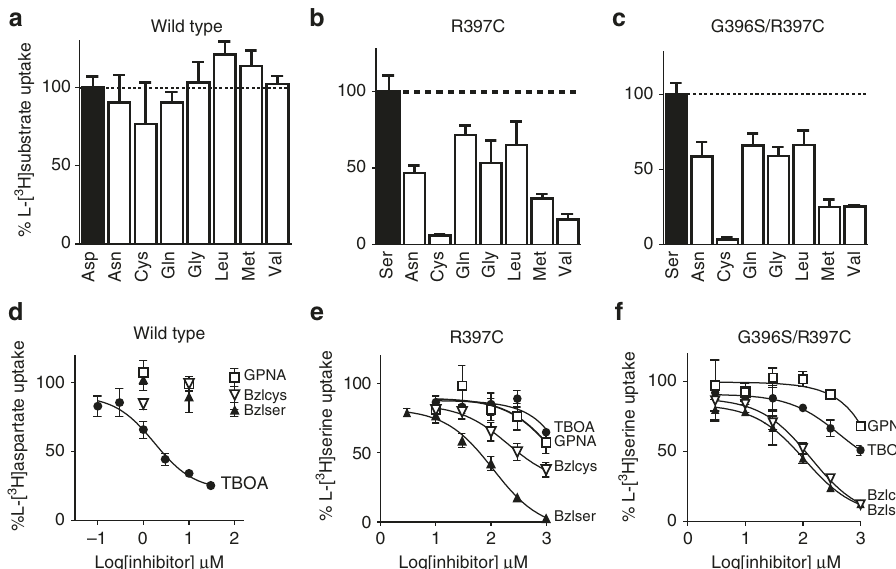
Fig. 4 Neutral amino acid and inhibitor selectivity in wild-type and mutant Glt Ph Initial rates of uptake in the presence of 100 nM L-[ 3 H]aspartate (black bar) for wild type a or 10 µ M L-[ 3 H]serine (black bars) for Glt Ph -R397C b and Glt Ph -G396S/R397C c and 100-fold unlabelled competitor as indicated on the x -axis (white bars). Values are normalised to initial rates of L-[ 3 H]substrate uptake alone, n = 3 ± SEM. Concentration – response curves are shown for TBOA (closed circles), benzylserine (closed triangles), benzylcysteine (open triangles) and GPNA (open squares) in wild-type Glt Ph d , Glt Ph -R397C e and Glt Ph -G396S/R397C f . Values shown represent mean ± SEM, n ≥